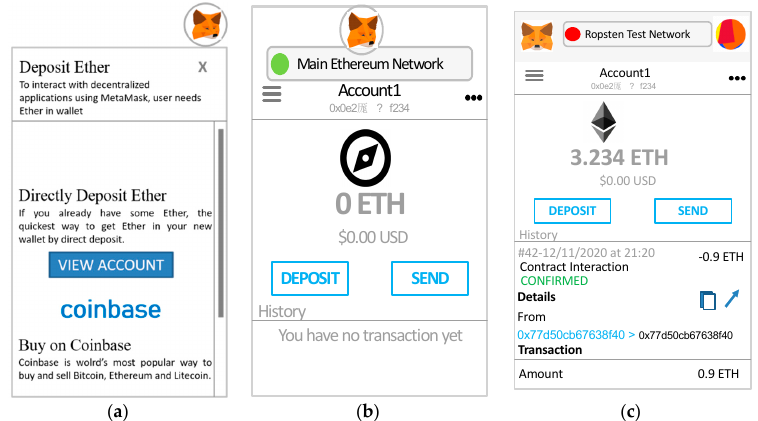
Figure 7. ( a ) Coinbase account to see the transaction details. ( b ) Main Ethereum network details. ( c ) Analyzing transaction details in Metamask Ropsten Test Network.